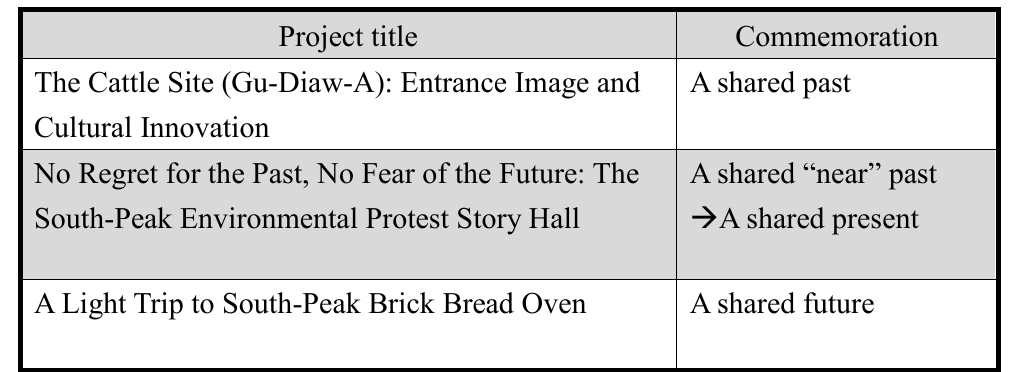
Table 1. Winning projects and